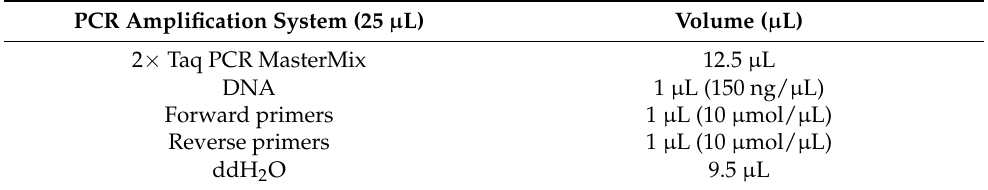
Table 1. PCR reaction conditions.